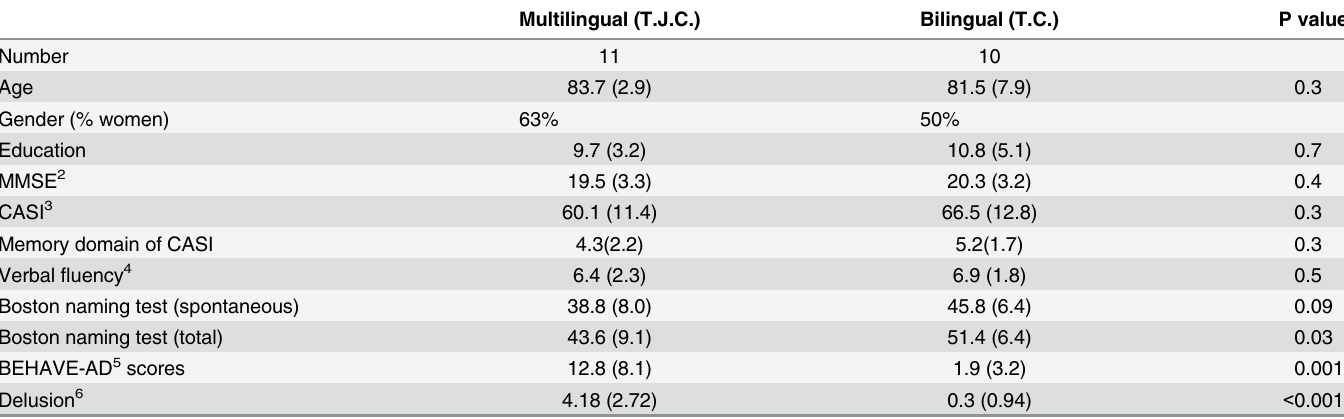
Table 1. Demographic and neuropsychological test results.